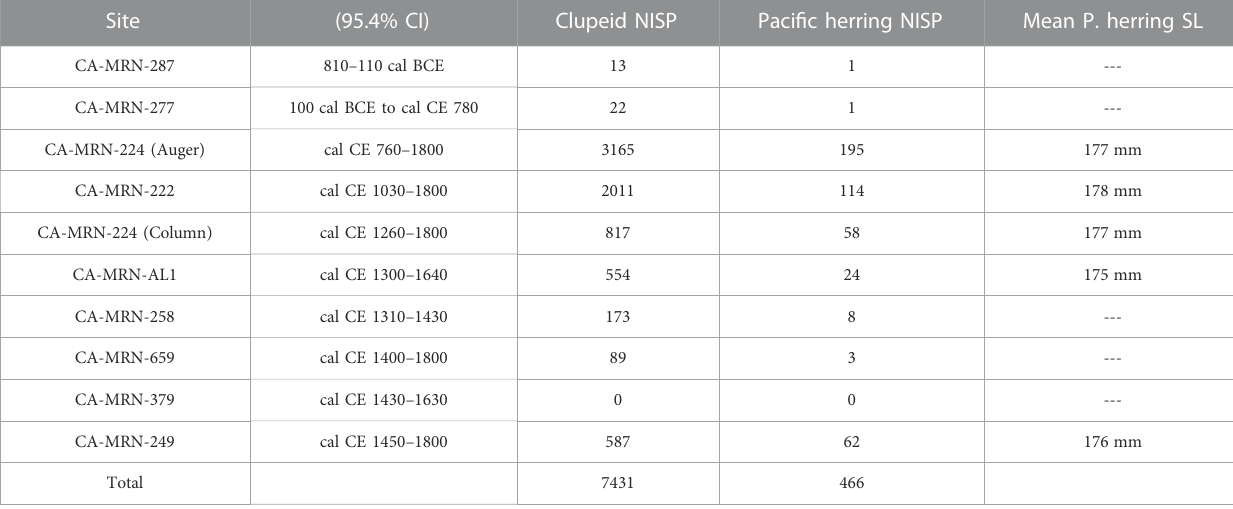
TABLE 2 Point Reyes National Seashore sites, calibrated radiocarbon dates, clupeid NISP, Paci fi c herring NISP, and mean Paci fi c herring